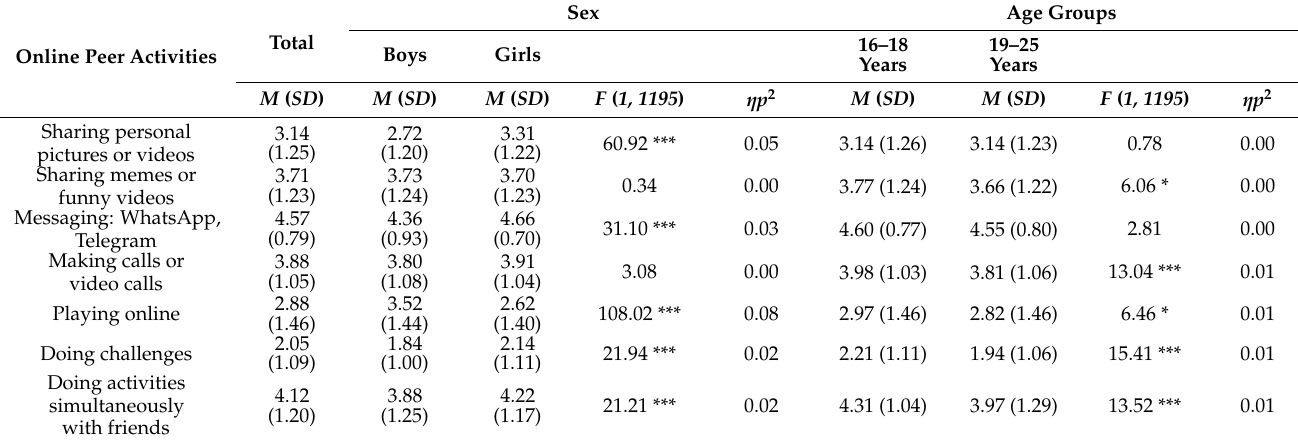
Table 3. Descriptive and MANOVA statistics for online peer activities by sex and age